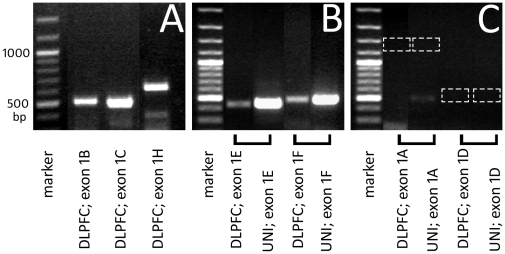
Endpoint PCR detection of GR exon 1 mRNA transcript variants in the DLPFC.A) strong amplification of GR-1B, GR-1C and GR-1H variants was evident in DLPFC cDNA, B) weaker amplification of GR-1E and GR-1F variants was observed in the DLPFC, but strong amplification was observed in universal human cDNA, C) GR-1A and GR-1D variants were detected neither in the DLPFC nor in universal cDNA. UNI- universal human cDNA.